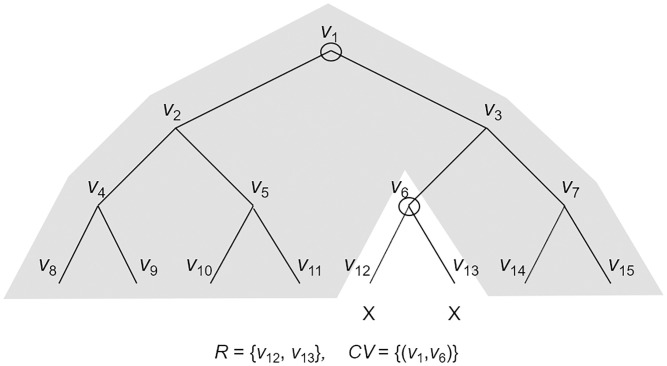
A cover set for R = {v12, v13} in the SD method.